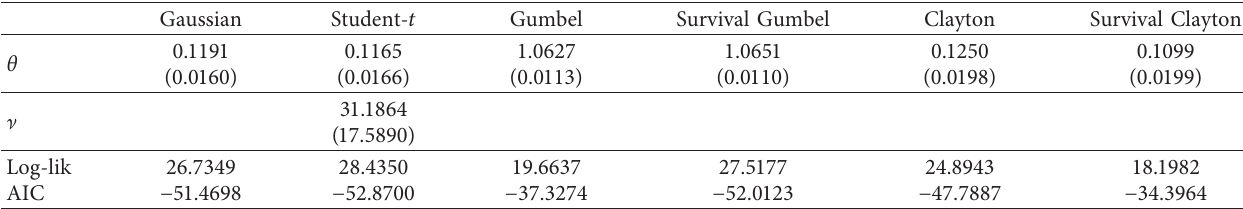
Table 5: Estimation results for various Copulas.